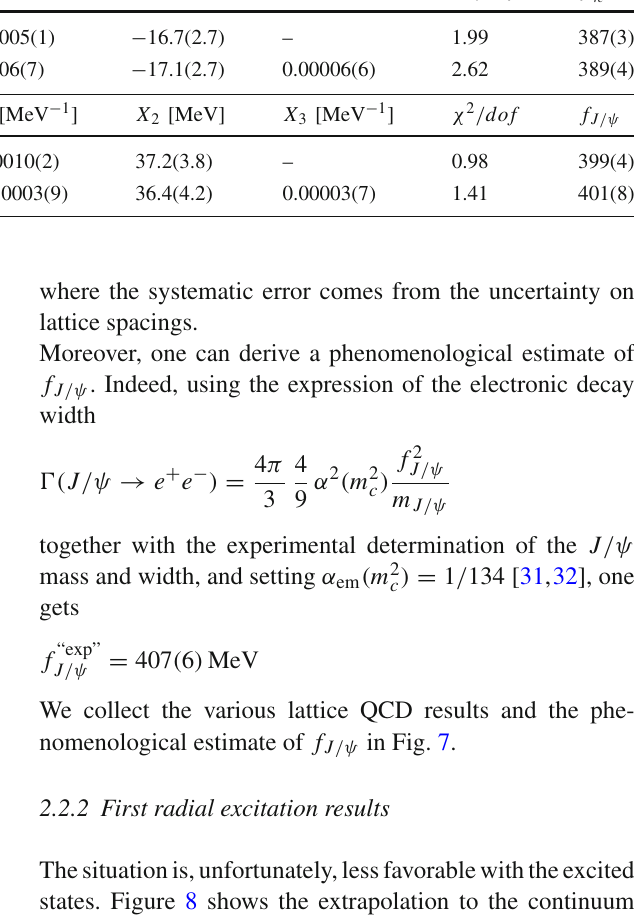
(left panel) and f J /ψ (right panel) by linear expressions in m 2 π and a 2 c c